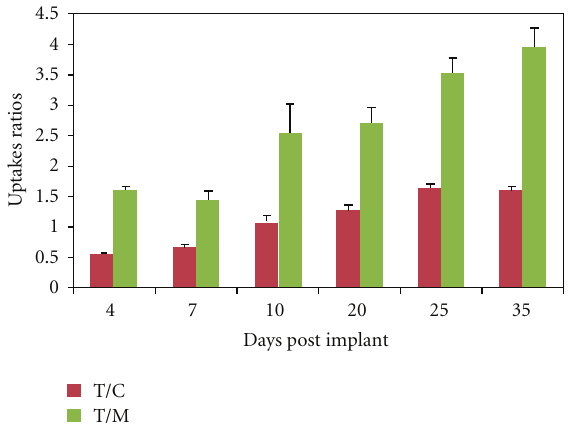
Figure 9: Quantitative analysis of 99m Tc-NTP 15-5 accumulation in chondrosarcoma against time after implant. Results are expressed as Tumour/Muscle and Tumour/Cartilage uptake ratios (T/M and T/C, resp.). Mean values + standard deviation are presented at each time